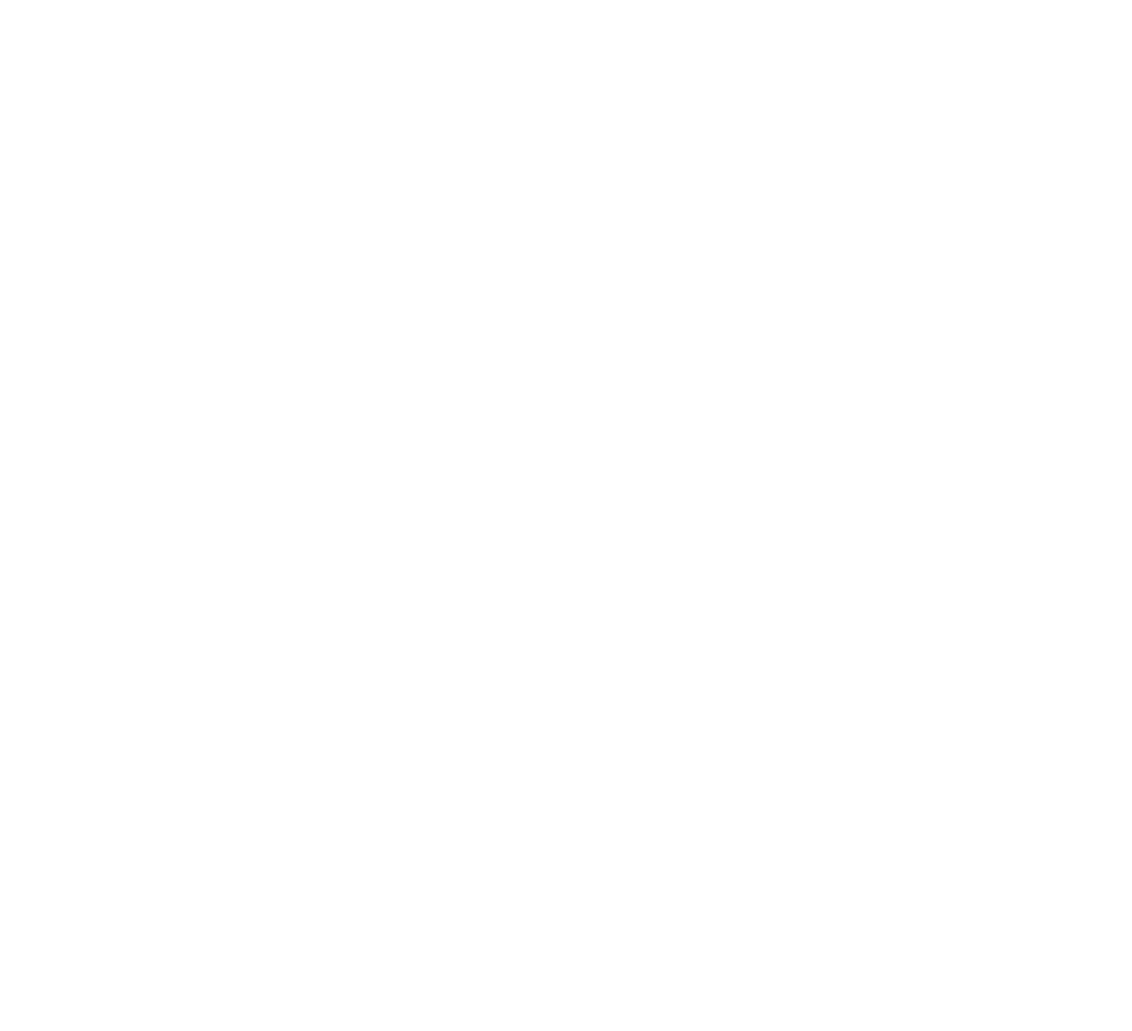
listed in the pathway (solid red box) and genes that are not in the pathway, but are located proximal to PHA synthesis genes (dotted red box). Genes in the same operon are identically color-coded. *, transcriptional change is significant ( ≥ 3-fold, all limitation-to-excess pairwise